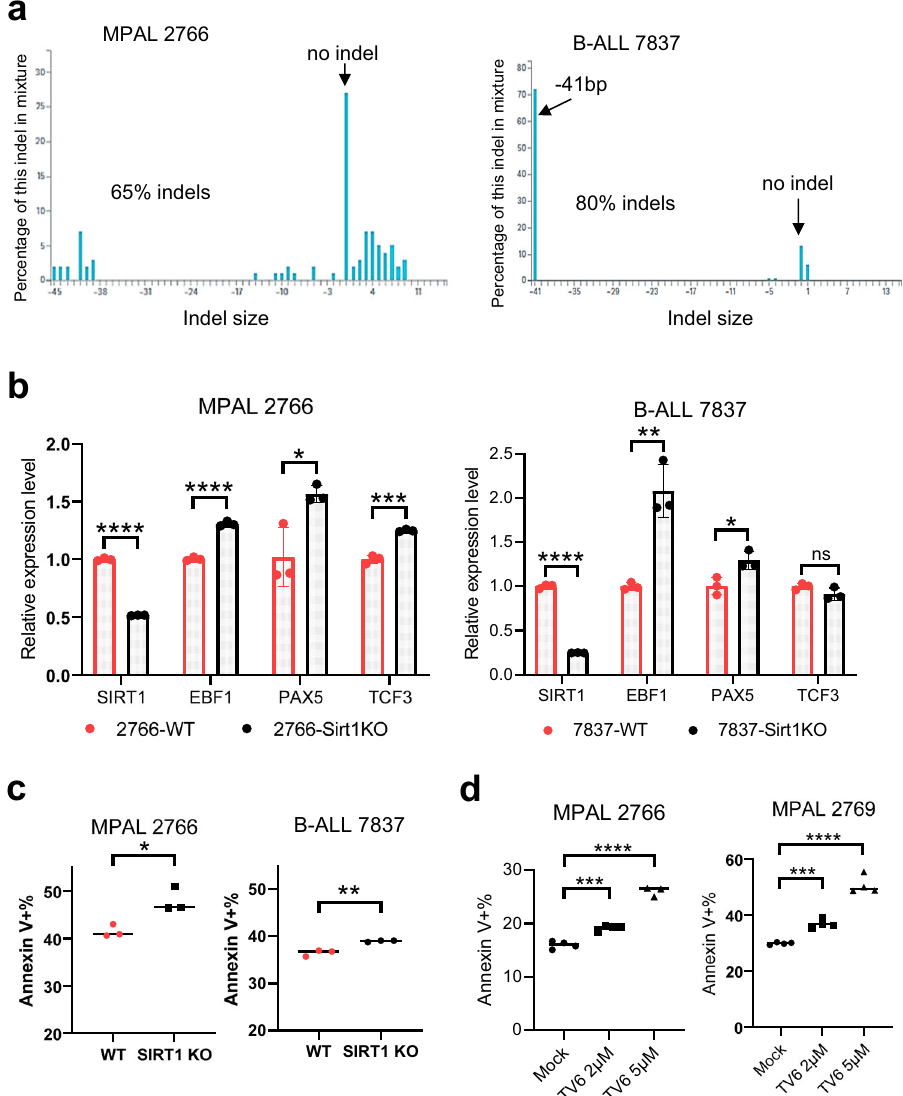
Fig. 6 Effects of SIRT1 knockout and inhibition on human primary leukemia cells. a CRISPR-mediated gene knockout of SIRT1 in human primary B/M MPAL and B-ALL cells. Indel size distribution and percentage of each indel at day 3 after electroporation were shown. There were 18% inframe indels in MPAL cells whereas inframe indels in B-ALL cells were below detection limit. b RT-qPCR analysis of SIRT1 and its target genes at day 3 after electroporation in MPAL and B-ALL cells. Wild type (WT) were mock knockout samples undergone the same procedures without sgRNAs. SIRT1 RT-qPCR primers were located at the exon 4 – 5 junction. c Apoptosis analysis of primary leukemia cells after SIRT1 KO at day 6. d Apoptosis analysis of two primary adult B/M MPAL samples 3 days after treatment with SIRT1 inhibitor tenovin-6 (TV-6). * P < 0.05; ** P < 0.01; *** P < 0.001; **** P < 0.0001. Error bars represented one standard